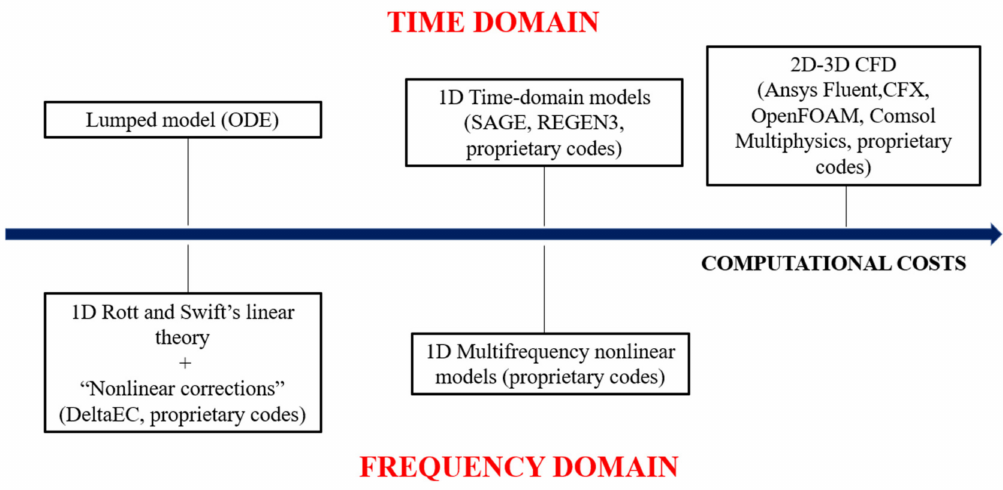
Figure 1. Overview of modeling approaches in thermoacoustics.